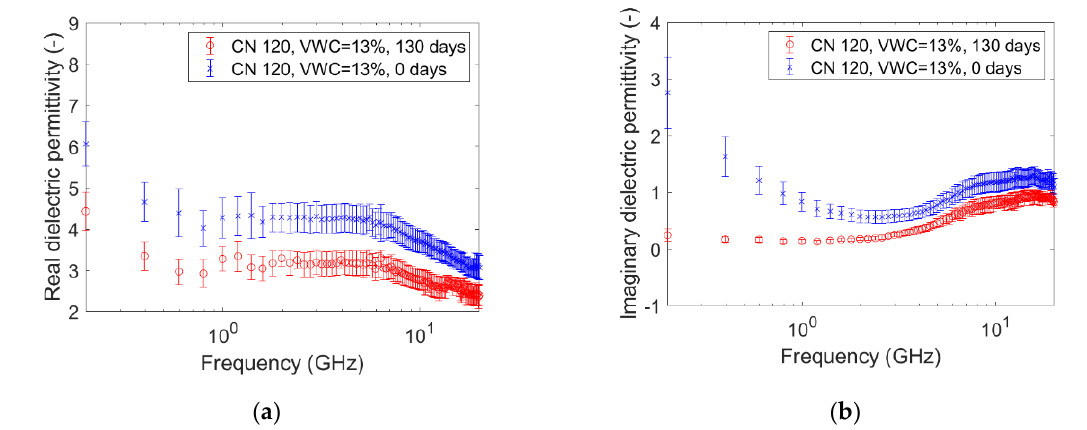
Figure 5. Complex dielectric permittivity before bioremediation and after 130 days: real part ( a ), imaginary part ( b ). Microcosm: C/N = 120, volumetric water content = 13%.